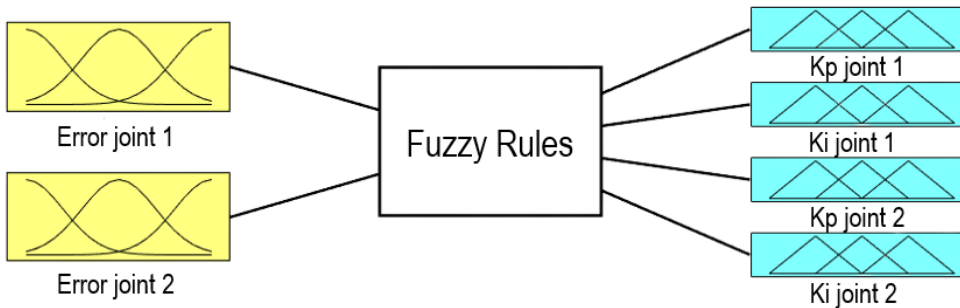
Figure 8. Fuzzy structure for PI gain scheduling.